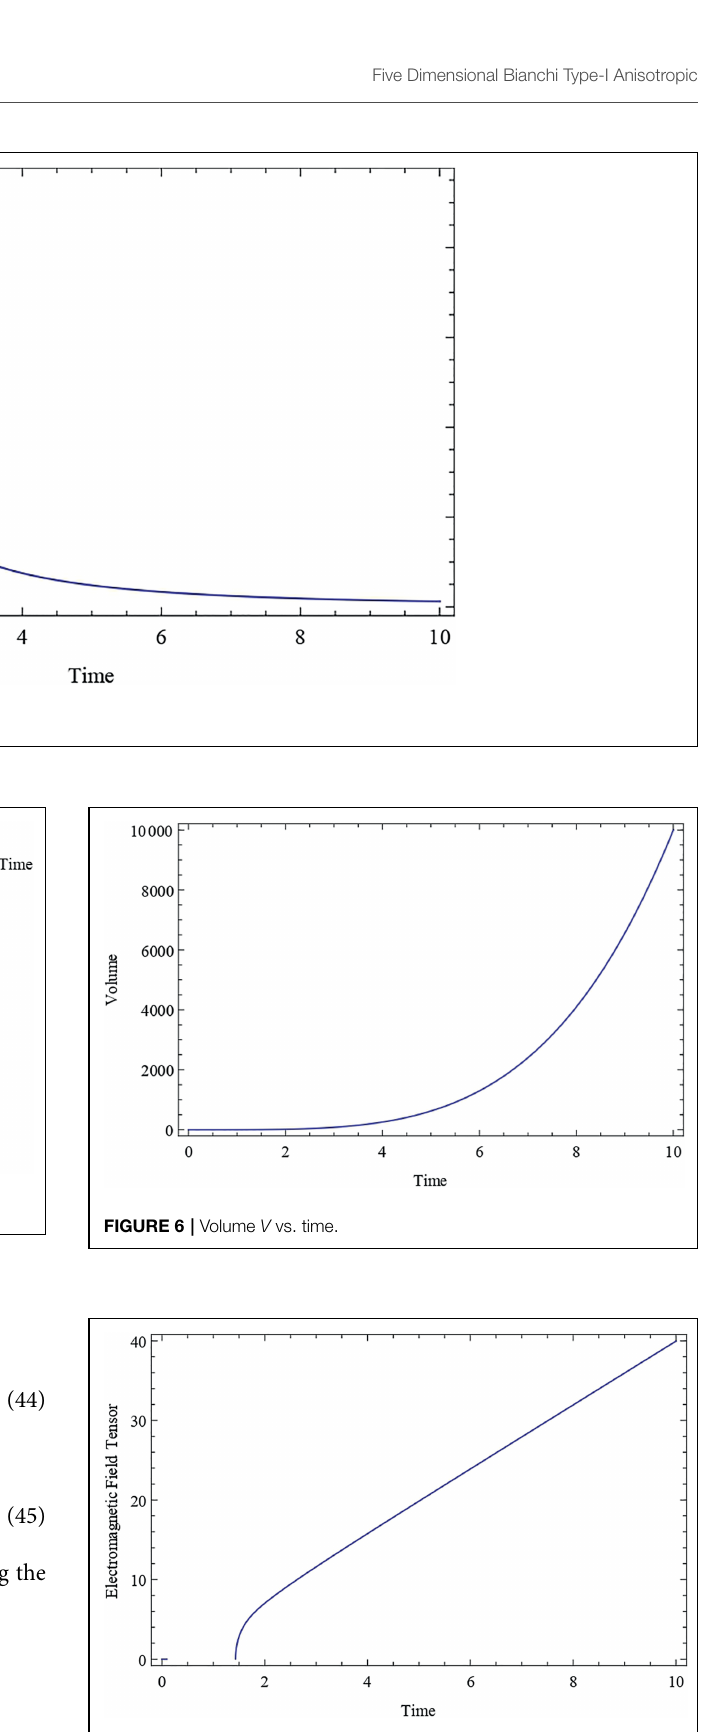
FIGURE 7 | Electromagnetic Field tensor F 15 vs.